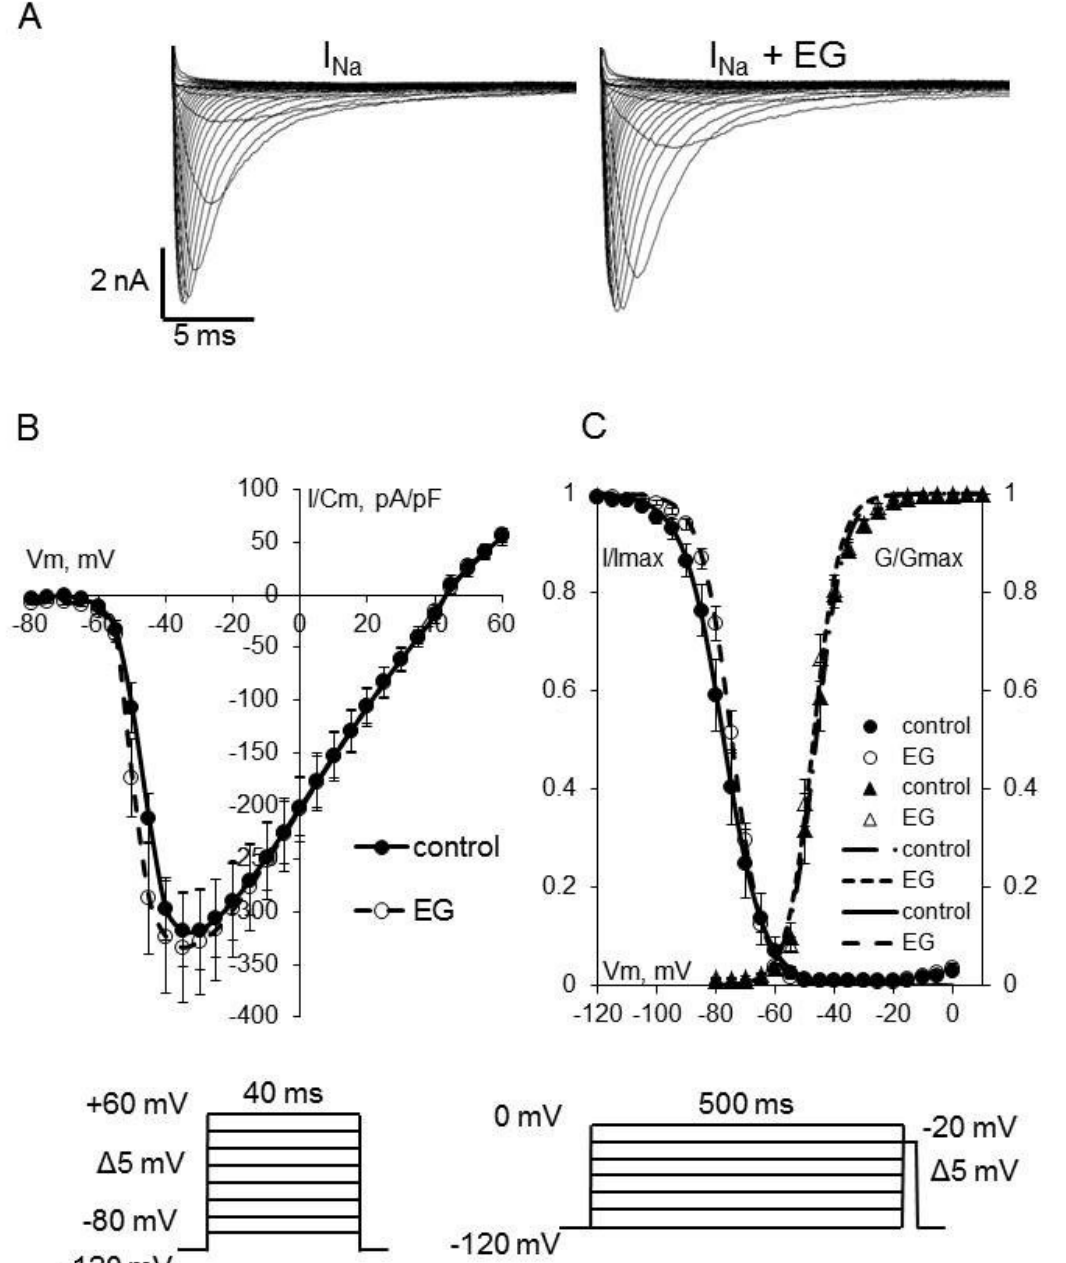
Figure 2. ( A ) Representative whole–cell current traces of I Na in freshly isolated ventricular cardiomy- ocytes from zebrafish in control (left) and after 2 h incubation with 5 µ M empagliflozin (right). ( B ) The current density–voltage relationship of the I Na in control ( n = 13) and in empagliflozin–treated ( n = 14) cardiomyocytes. ( C ) The voltage dependence of steady–state activation and inactivation. The solid and dash lines show least–squares fits to the Boltzmann function. Voltage clamp protocols used to determine activation and inactivation characteristics are shown at the bottom.